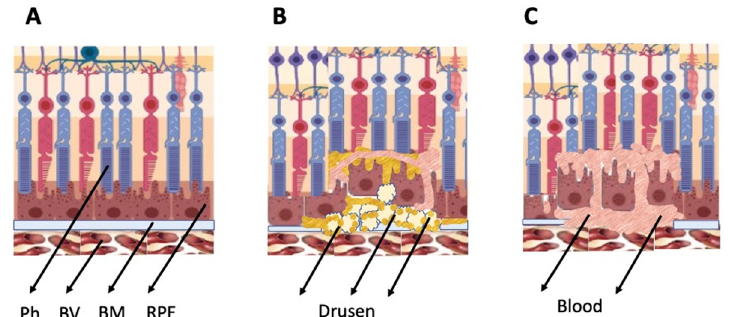
Figure 3. Schematic representation of AMD-related changes in the eye. ( A )—normal eye; ( B )—“dry” AMD; ( C )—“wet” AMD. Ph—photoreceptors, BV—blood vessels, BM—Bruch membrane; RPE—retinal pigment epithelium.